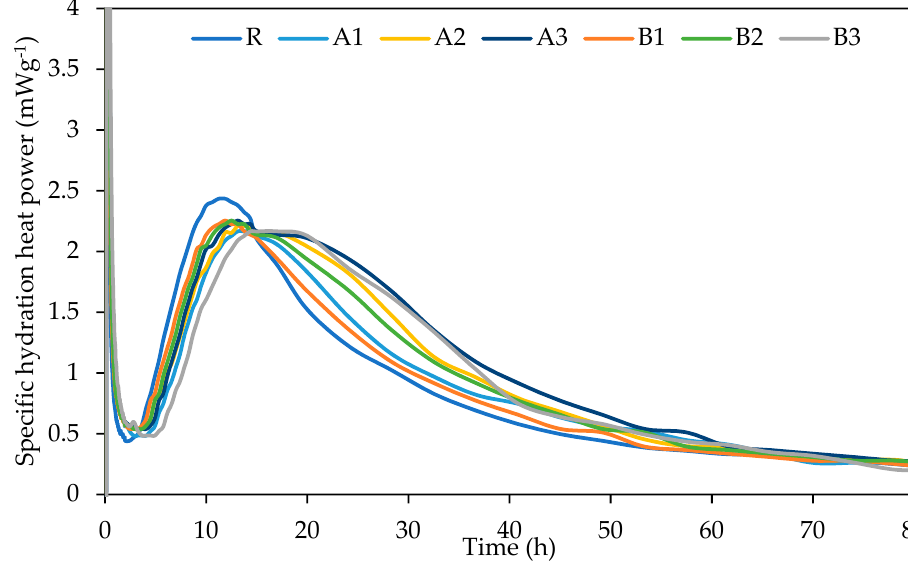
Figure 5. 3D XCT render of the A3 mixture sample (10 × 10 × 10 mm) with revealed SAP particles (blue color).